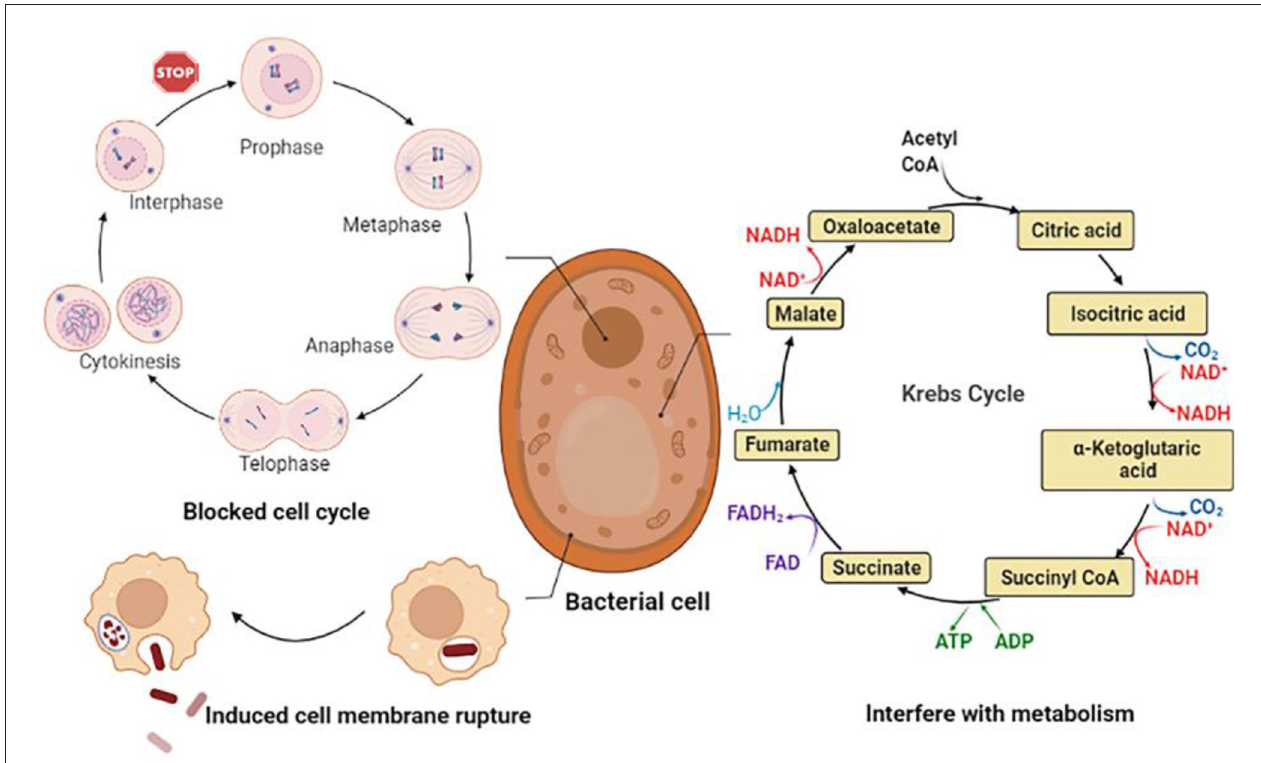
FIGURE 6 | Bacteriostatic mechanism of